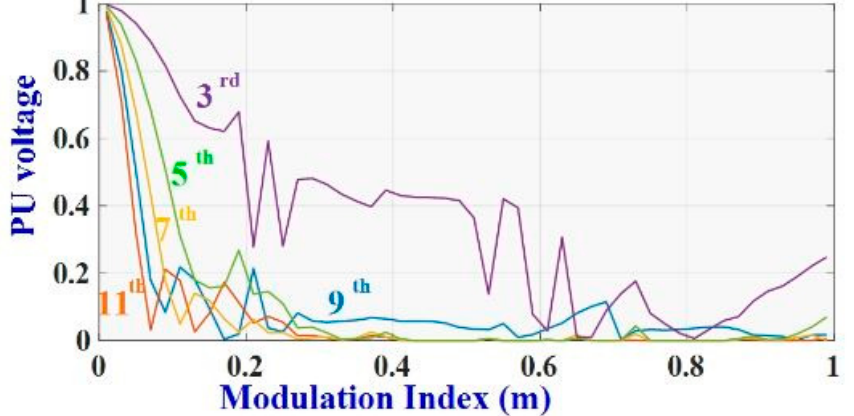
Figure 13. Harmonic components present in the voltage across phase A.